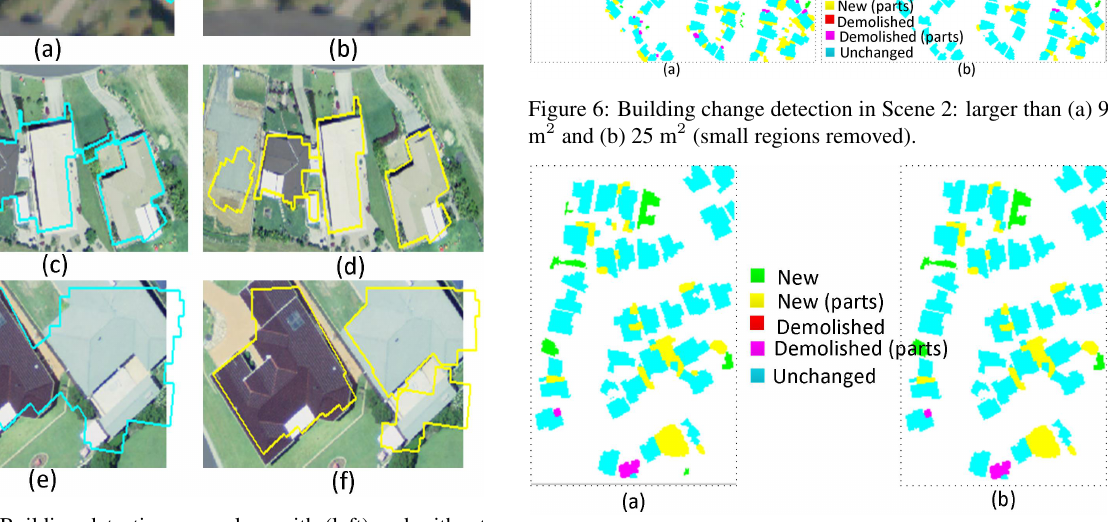
Figure 7: Building change detection in Scene 3: larger than (a) 9 m 2 and (b) 25 m 2 (small regions